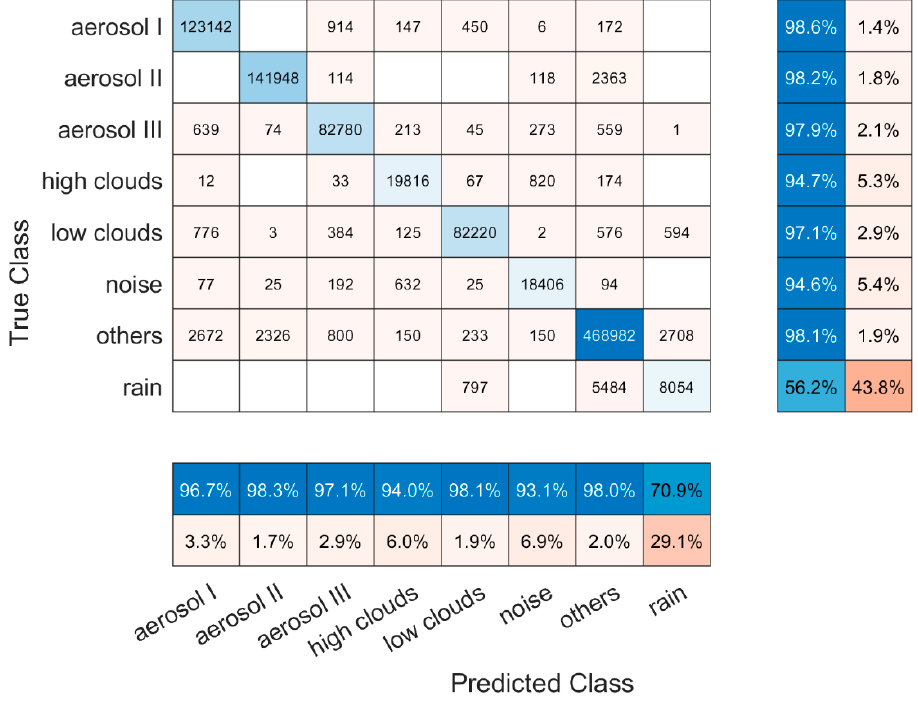
Figure 6. The evaluation of the classification model: the confusion matrix chart of the classification model with the testing data set, which is 90% of all data points. The number in the matrix is the count of data points for each class, and blanks indicate no such classes are classified. Blue colors indicate corrected predicted (TP), and red colors incorrectly predicted data (FN). Darker color means a higher percentage accordingly. The row summary is TPR (blue) and FNR (red) for each true class (row), respectively. The column is PPV (blue) and FDR (red) for each predicted class (column), respectively.